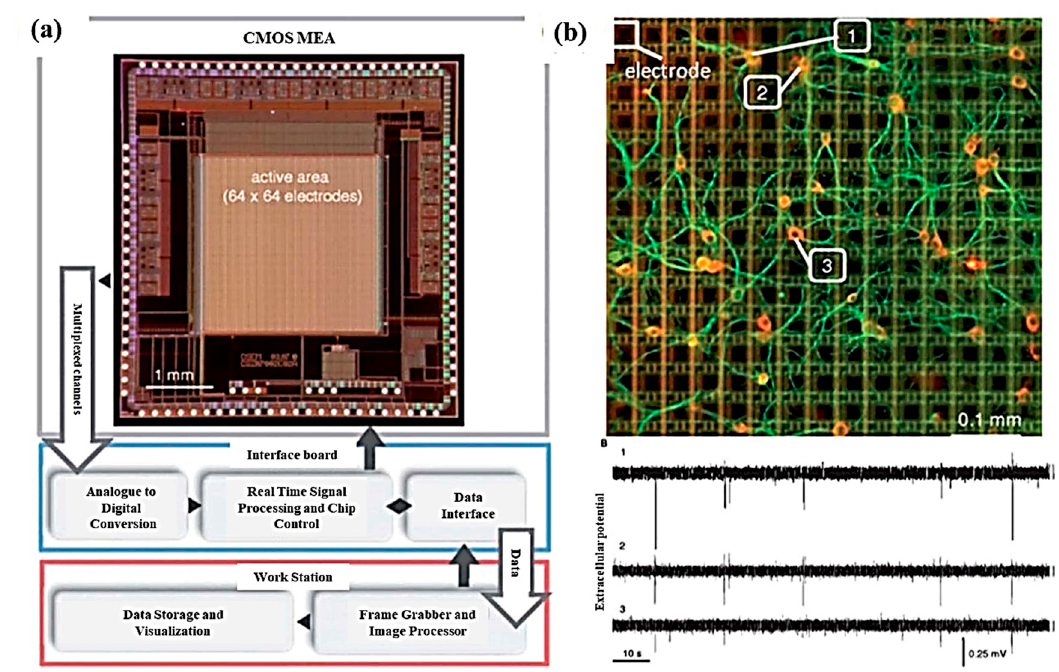
Figure 7. ( a ) Electrophysiological platform integrated with a complementary metal–oxide–semiconductor (CMOS) microelectrode array chip, the interface board, and a workstation. ( b ) Immunofluorescence imaging of single-neurons on the chip and the electrophysiological activity of three selected neurons. Reproduced from [83] with the permission of the Royal Society of Chemistry.